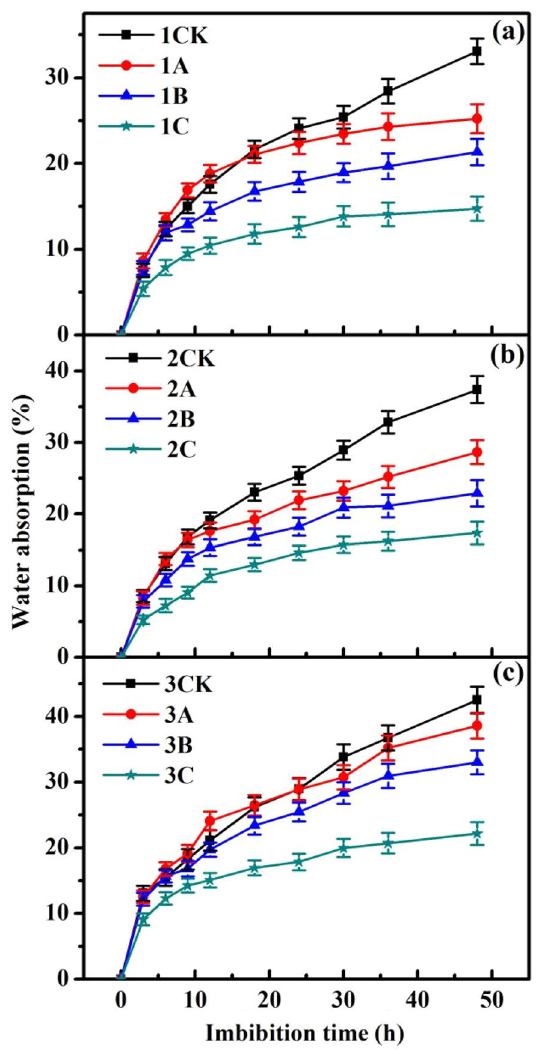
Figure 1. Relative water absorption of rice seeds as a function of time in ( a ) XD10-01 ( ♀ ), ( b ) BX10 ( ♂ ), and ( c ) XJ (04)-08 subjected to different doses of N ion beam irradiation. XD10-01 ( ♀ ), BX10 ( ♂ ), and XJ(04)-08 are numbered 1, 2, and 3, respectively. The four ionizing radiation doses, namely, 0 × 10 17 , 3.0 × 10 17 , 5.0 × 10 17 , and 7.0 × 10 17 ions/cm 2 , of each experimental material are labelled CK, A, B, and C, respectively. The means (± SEs) were calculated from three replicates per treatment. The same scheme applies to the figures